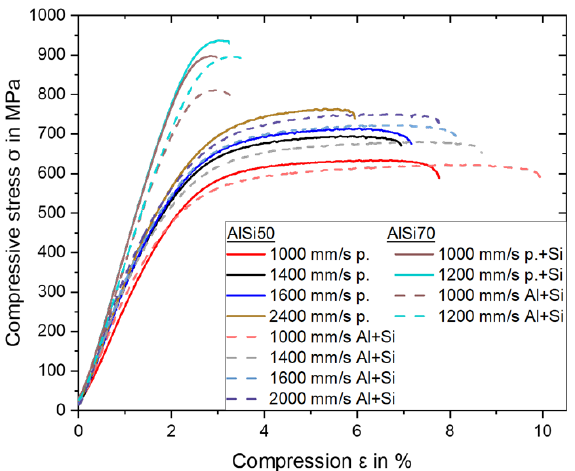
Figure 7. Compressive stress-compression diagram for samples of both AlSi50 variants fabricated with four scan velocities and for samples of both AlS70 variants produced with two scan velocities. Analogous to the hardness, the 0.2% OYS and the CS also rose with increasing scan velocity, independent of the Si content and powder variant. Simultaneously, the fracture compression decreased. In the case of AlSi50 p., a rise in scan velocity from 1000 mm/s to 2400 mm/s caused an increment of the 0.2% OYS from 459 ± 27 MPa to 576 ± 35 MPa and a rise of CS from 584 ± 15 MPa to 742 ± 11 MPa, while the fracture compression declined from 5.6 ± 0.5% to 3.7 ±